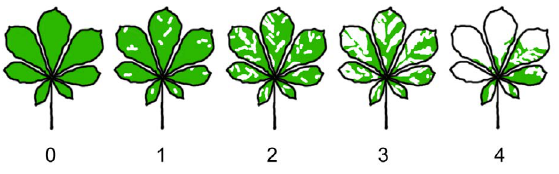
Figure 1. Scoring damage to horse-chestnut leaves. Diagrams of leaf damage given to participants to score damage to horse-chestnut Aesculus hippocastanum leaves, adapted from [12]. The accompanying descriptions were: 0=The leaf is completely green. No evidence of moth attack; 1=Just a couple of whitish/brown patches on the leaf; 2=There is more green than white/brown on the leaf; 3=You can’t decide whether green or white/brown dominates. It’s about half green leaf and half whitish/brown patches; 4=The whitish/brown patches definitely cover more than half the leaf. They may cover all the leaf.